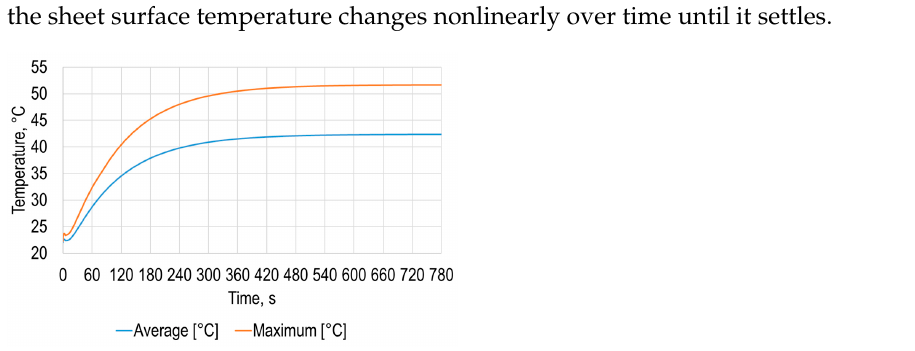
Figure 3. Average and maximum temperatures of the opposite to the heating polymer sheet surface.